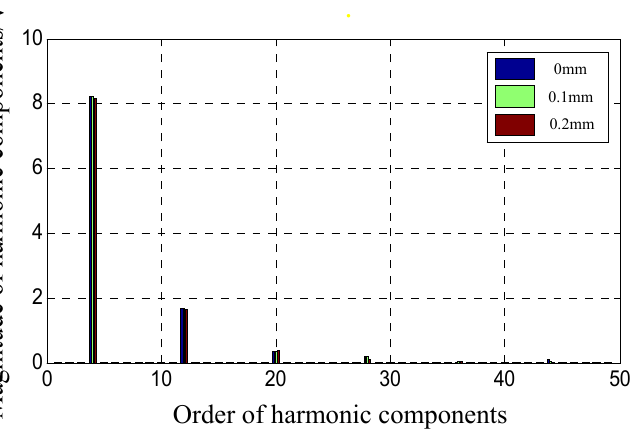
Figure 12. Comparison of harmonic components of EMF without skew when the motor rotates once.